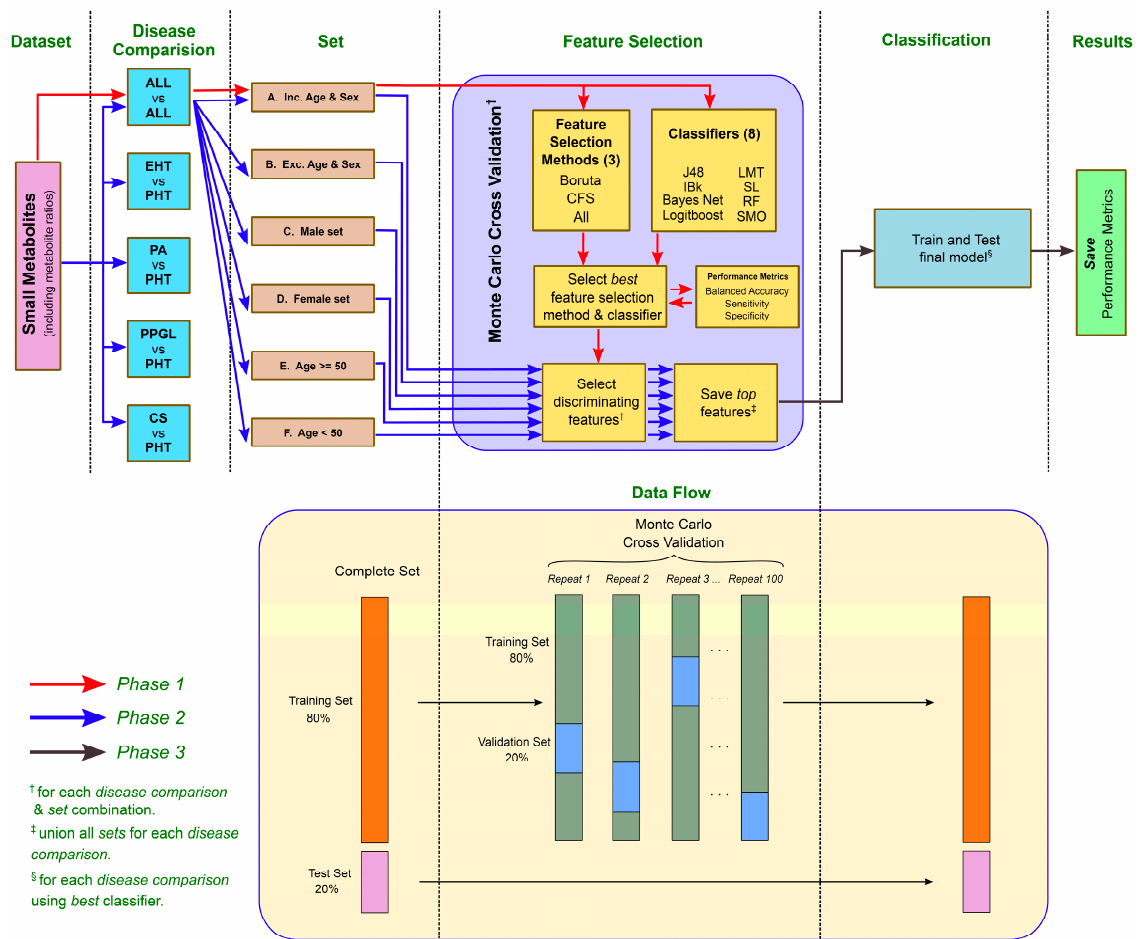
Figure 1. ML analysis pipeline showing the three phases of the analysis and corresponding data flow.